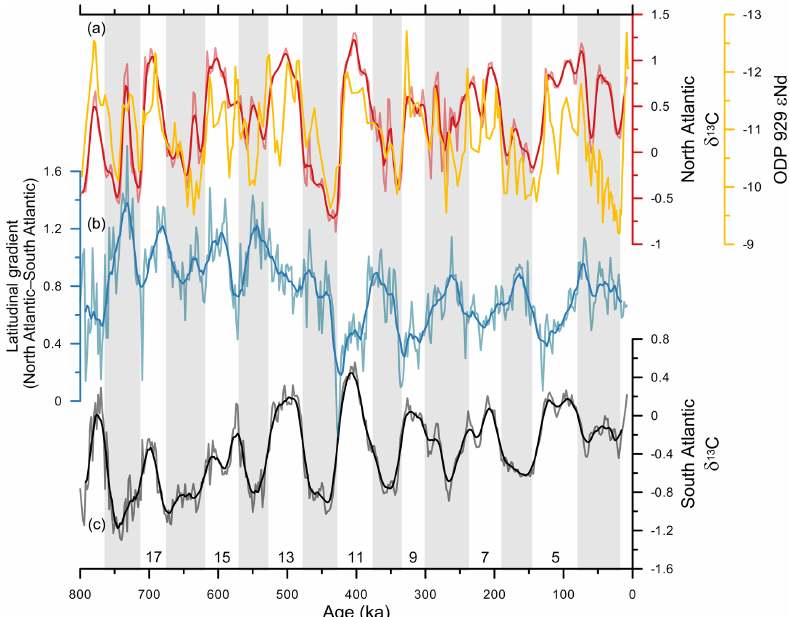
Figure 10. Latitudinal ∂ 13 C gradient. (a) North Atlantic regional ∂ 13 C stack plotted in ∂ 13 C space (red) authigenic ε Nd (yellow; Howe et al., 2017). (b) Latitudinal gradient of Atlantic ∂ 13 C regional stacks (North Atlantic minus South Atlantic; blue). Lower values demonstrate increased similarity between the records. (c) South Atlantic regional ∂ 13 C stack plotted in ∂ 13 C space (black). Vertical gray bars indicate glacial periods. Numbers represent Marine Isotope Stage numbers for